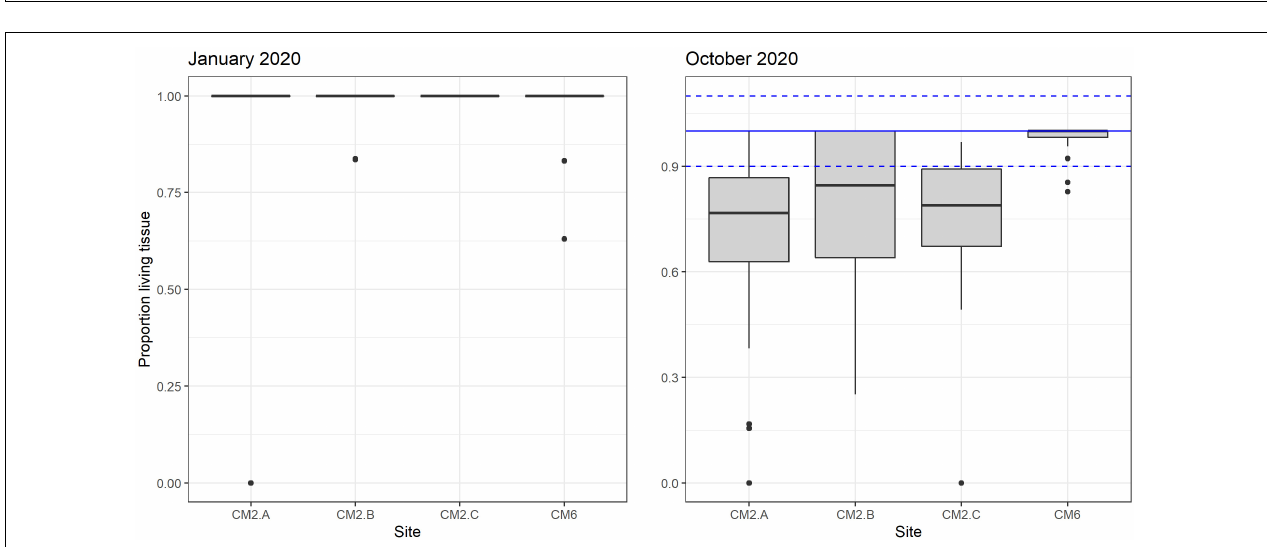
FIGURE 6 | Linear growth box plot for colonies that survived between January 2020 and October 2020 across monitored sites. Solid and dashed red lines in panel January 2020 indicate the average and confidence interval (CI 95%) of initial sizes at the moment of outplanting (November 2019), respectively. Solid and blue dash lines in panel October 2020 indicate average and confidence interval (CI 95%) of growth recorded in January 2020. Solid and dashed green lines indicate mean and confidence interval (CI 95) recorded in October 2020, respectively. Black dots represent outliers.